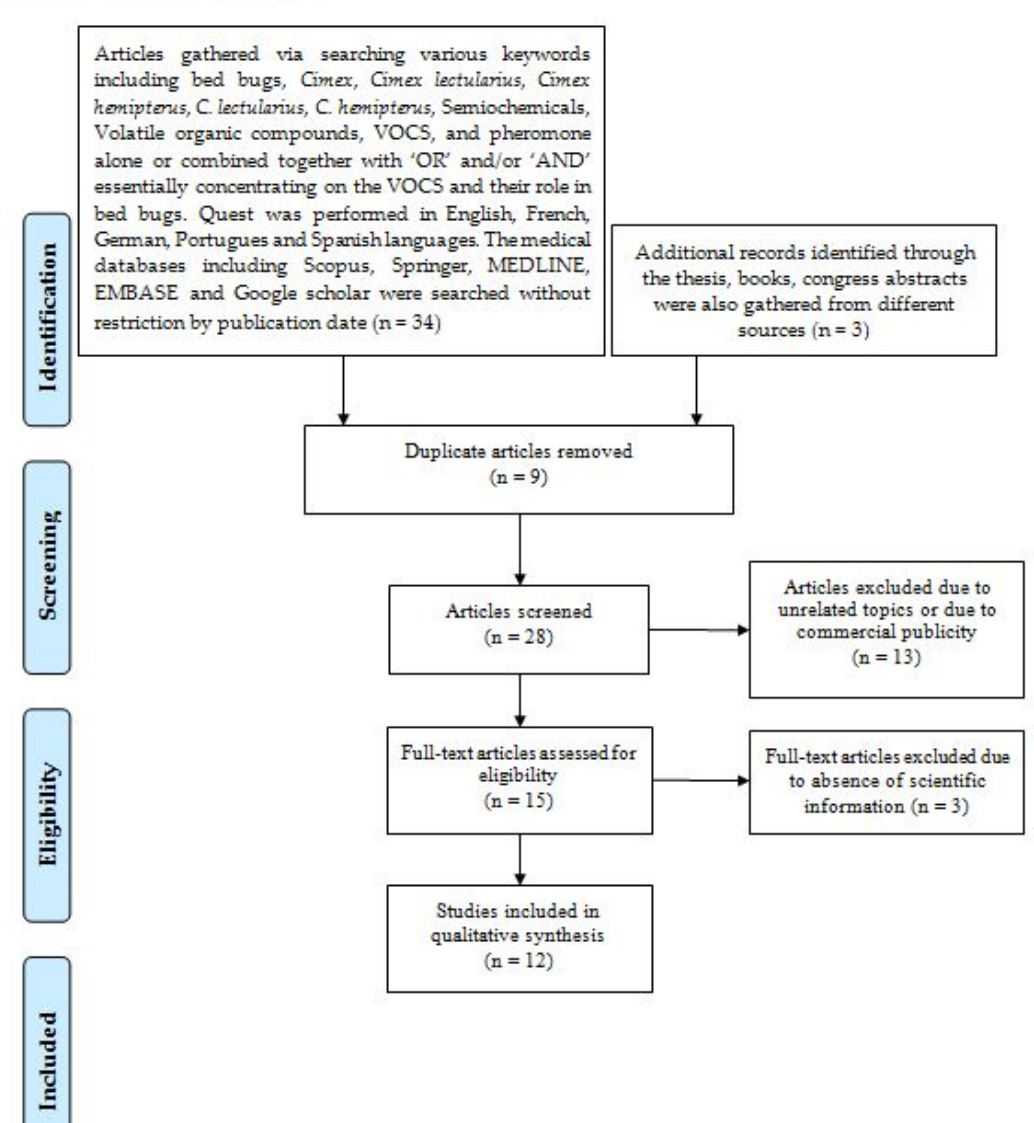
Figure 3. The literature quest strategy used in the present study.